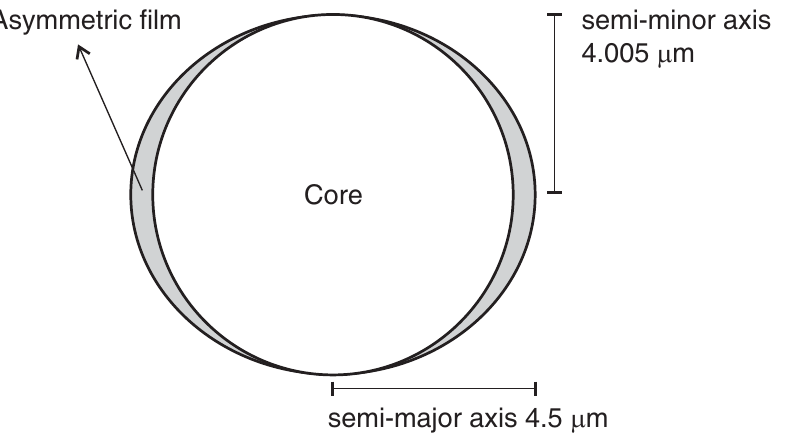
Figure 7. Fiber model geometry used in the computational simulation, representing a circular core and an elliptical